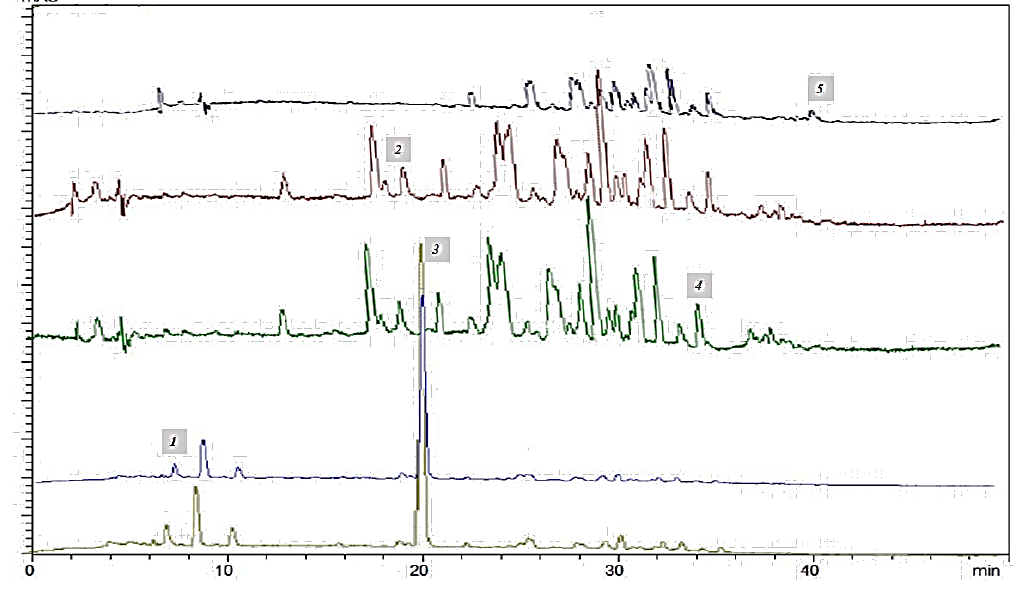
Figure 3. HPLC chromatogram of identified compounds in all the samples at the relative wavelengths to which they have been detected and quantified: 1. EGCG (λ = 280 nm); 2. Chlorogenic acid (λ = 327 nm); 3. Caffeine (λ = 273 nm); 4. Ferulic acid (λ = 325 nm); 5. Quercetin (λ = 365 nm).